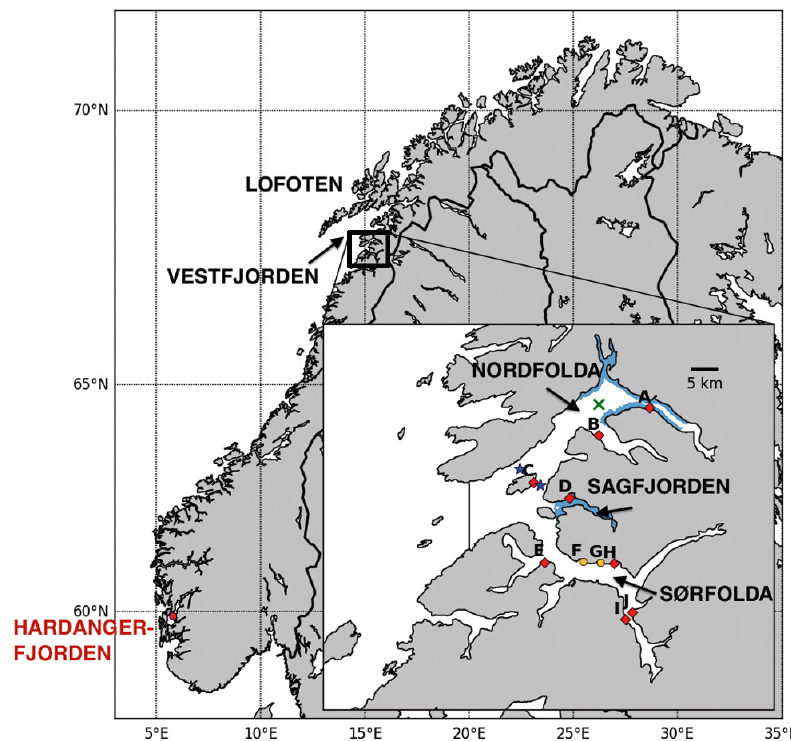
Fig. 1. The Folda fjord system on the northern coast of Norway. Red marks: ac- tive salmon farms; orange marks: fish farms not in production during the simu- lated period. Vertical profiles of temperature and salinity were measured at the locations indicated by the blue stars (7 March and 21 July 2010). Blue areas indi- cate the assumed residence areas for wild sea trout. The black line at the fjord mouth indicate the outer limit of calculated salmon lice retention. The green cross shows the position of buoy measuring current and salinity at 3 m depth and temperature at 4 m depth (2 July to 30 August